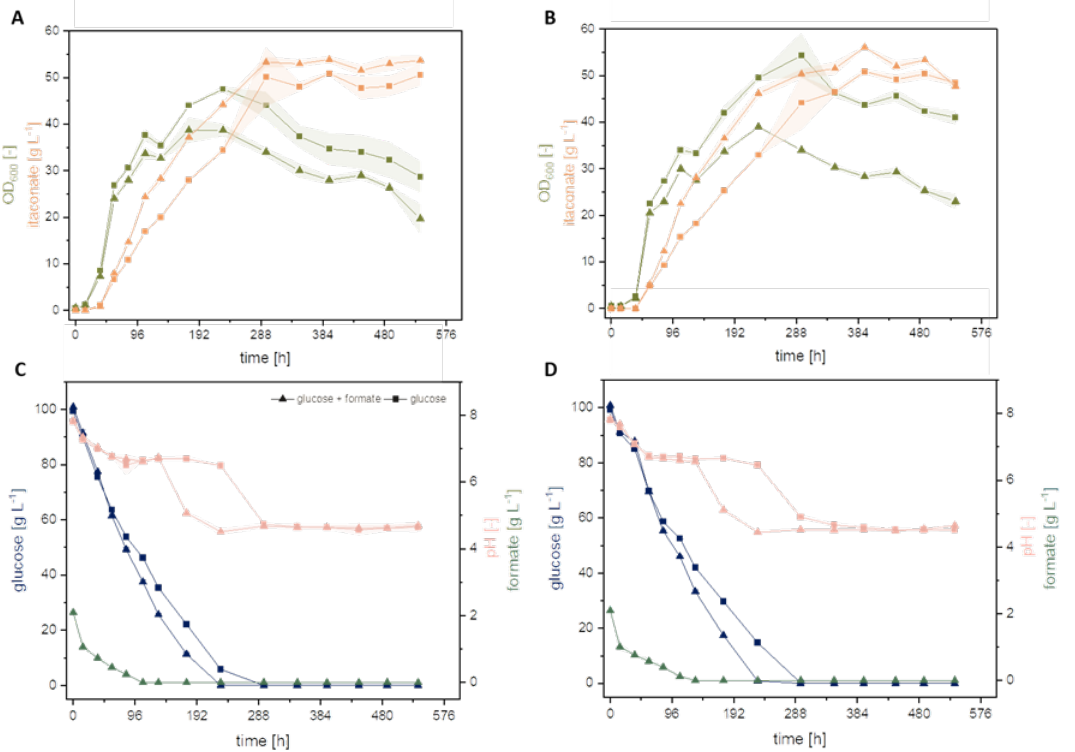
Figure 4. Formate co-metabolization of metabolically engineered U. cynodontis strains. ( A , C ) display cultivation of U. cynodontis ∆ fuz7 ∆ cyp3 ↑ P ria1 ; ( B , D ) of U. cynodontis ∆ fuz7 ∆ cyp3 P etef mttA ↑ P ria1 . Formate co-metabolization conditions are shown via ▲ and the respective glucose reference as ■ . Color code shows OD 600 (green), itaconate production (orange), glucose consumption (blue), sodium formate consumption (dark green), pH (light pink). Cultivations were carried out in shake flasks (see Section 2.1). MTM medium (33 g L − 1 CaCO 3 , 0.8 g L − 1 NH 4 Cl, 100 g L − 1 glucose) with 0 g L − 1